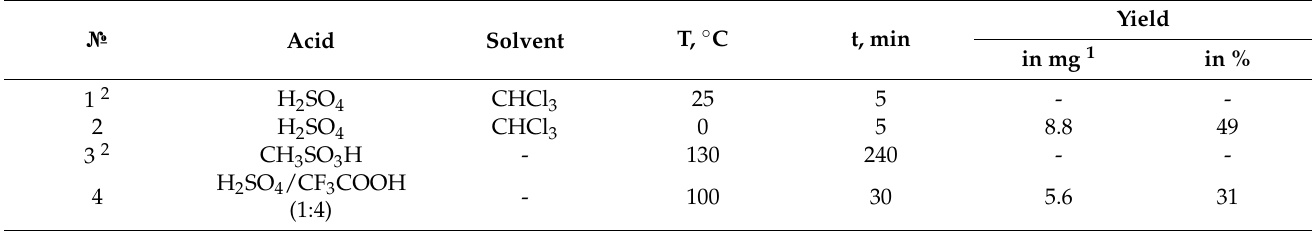
Table 2. Reaction conditions for demetallization of petroleum vanadyl